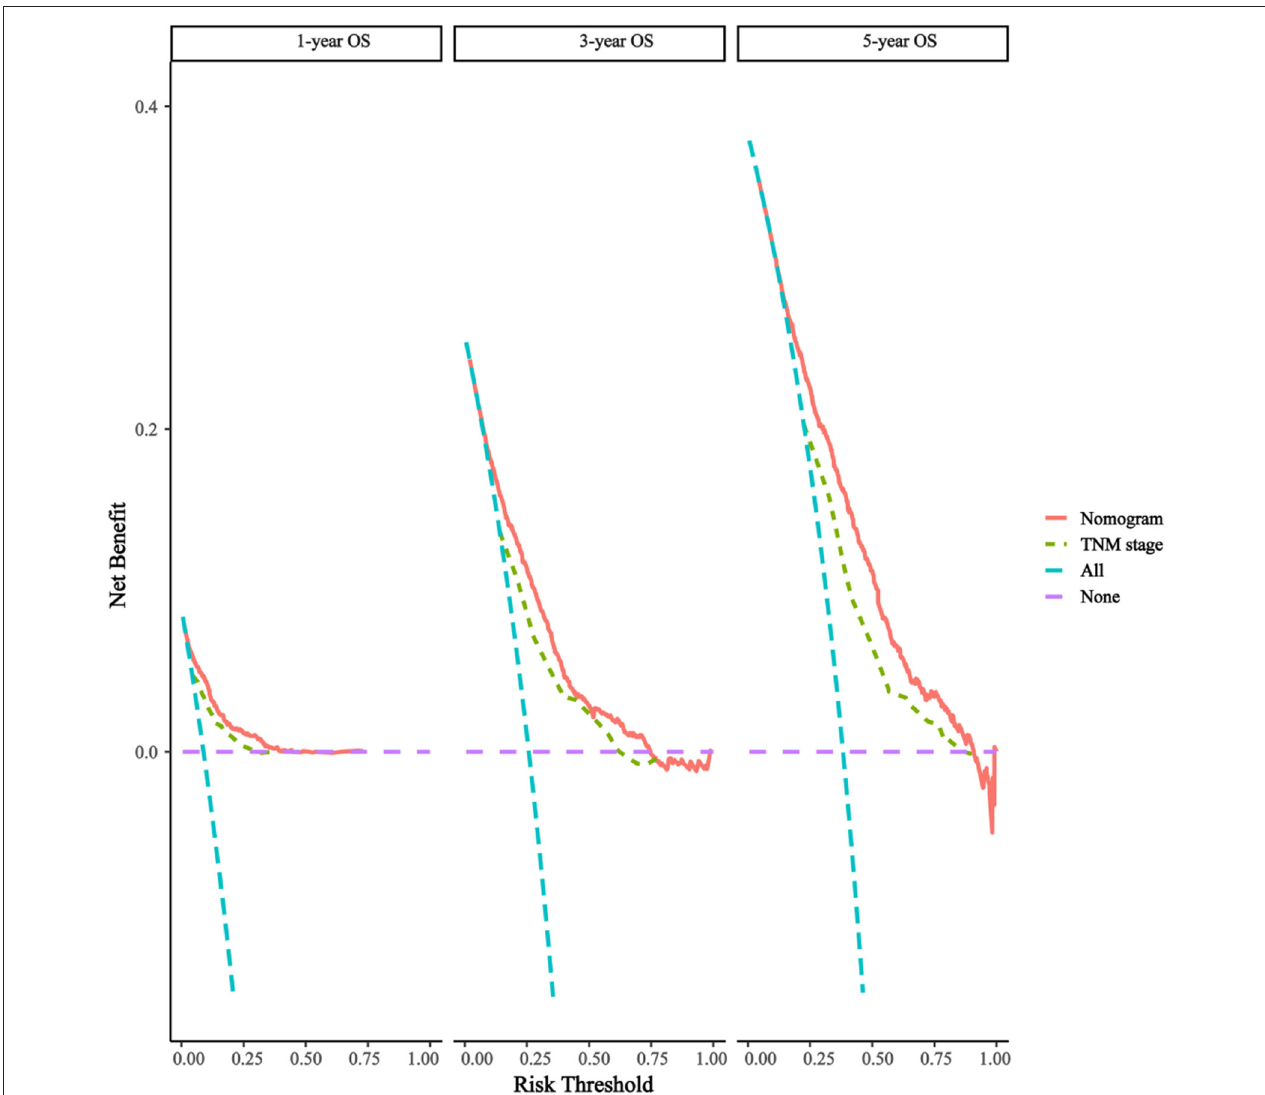
FIGURE 5 | Decision curves of the nomogram predicting OS. The x-axis represents the threshold probabilities and the y-axis measures the net benefit, which is calculated by adding the true positives and subtracting the false positives.